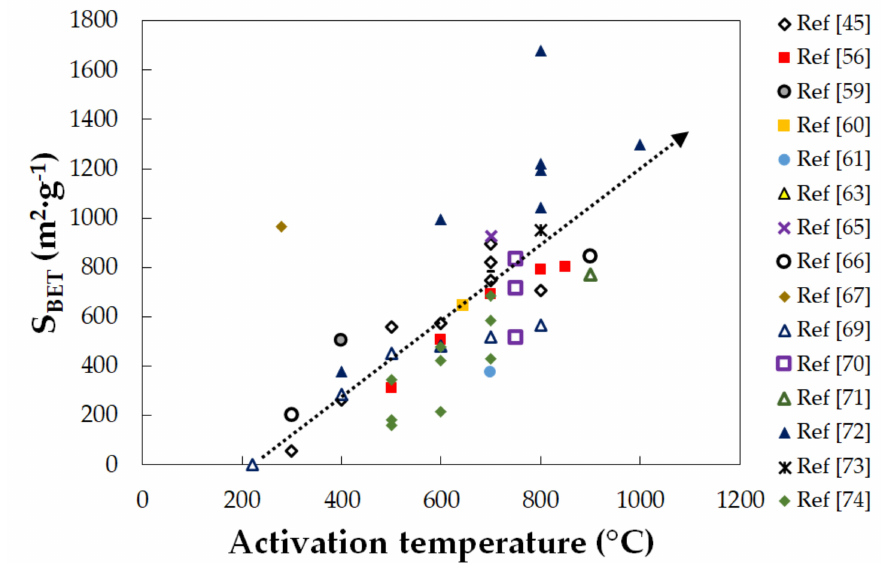
Figure 5. BET surface area of the activated carbons synthesized by FeCl 3 of di ff erent carbonaceous precursors versus the activation